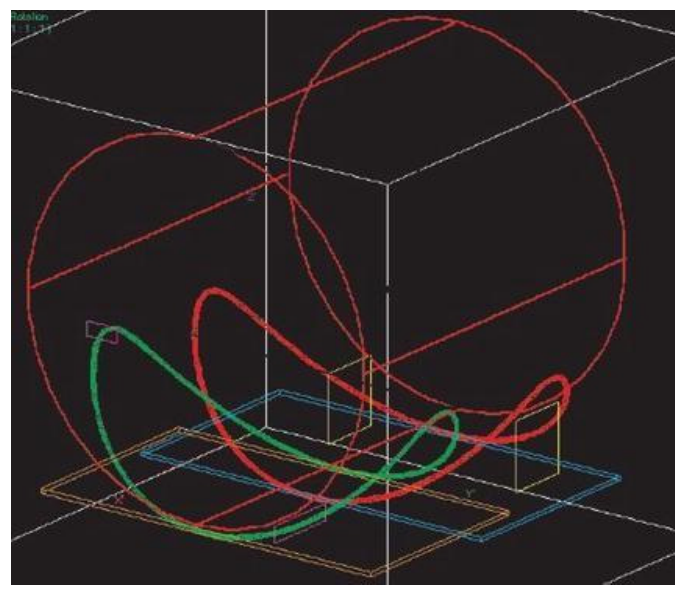
Figure 9. The designed two elliptical loops array. Reprinted from the [45].